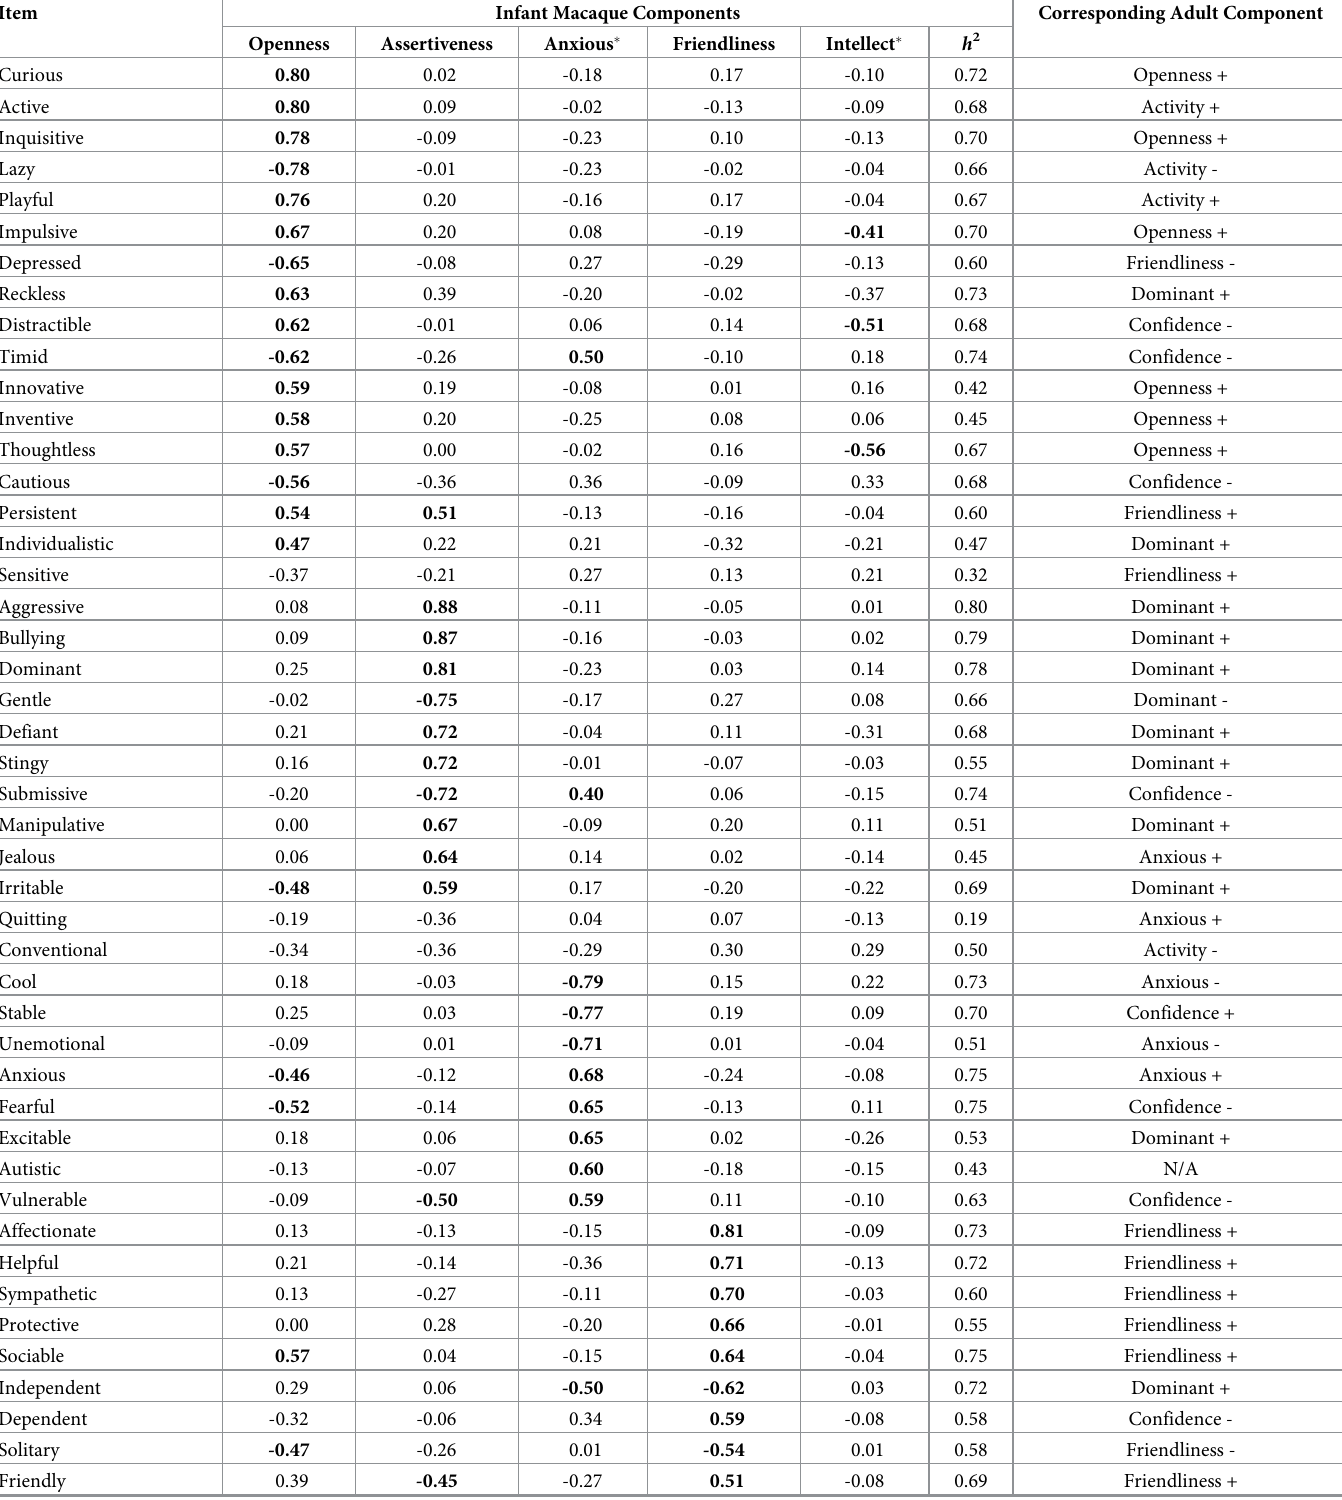
Table 2. Varimax rotated infant rhesus macaque